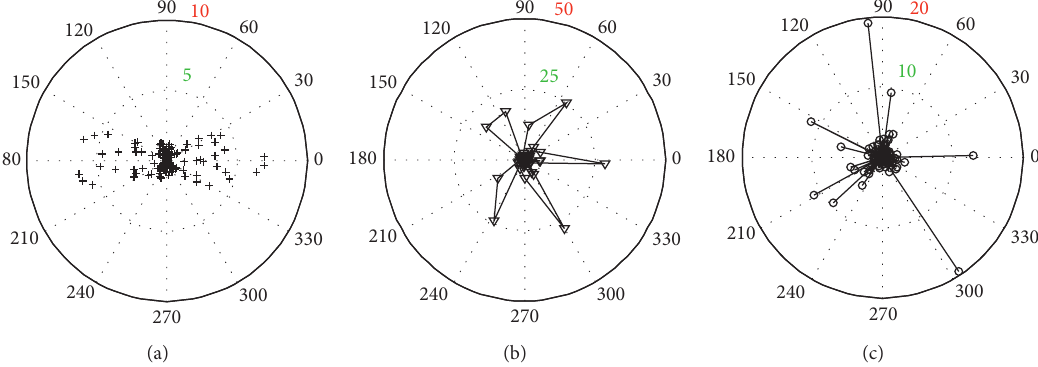
Figure 4: Changes of the three color components with time in polar coordinates. (a) H component, (b) V component, and (c) C